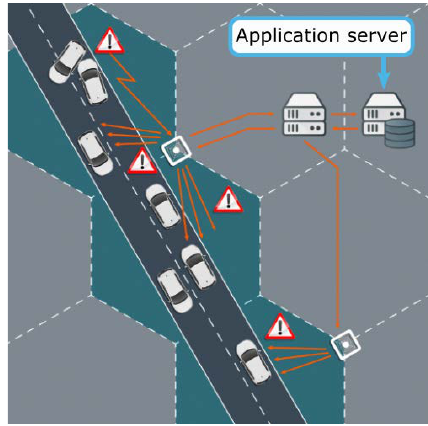
Figure 4. High Definition Local Map use case.